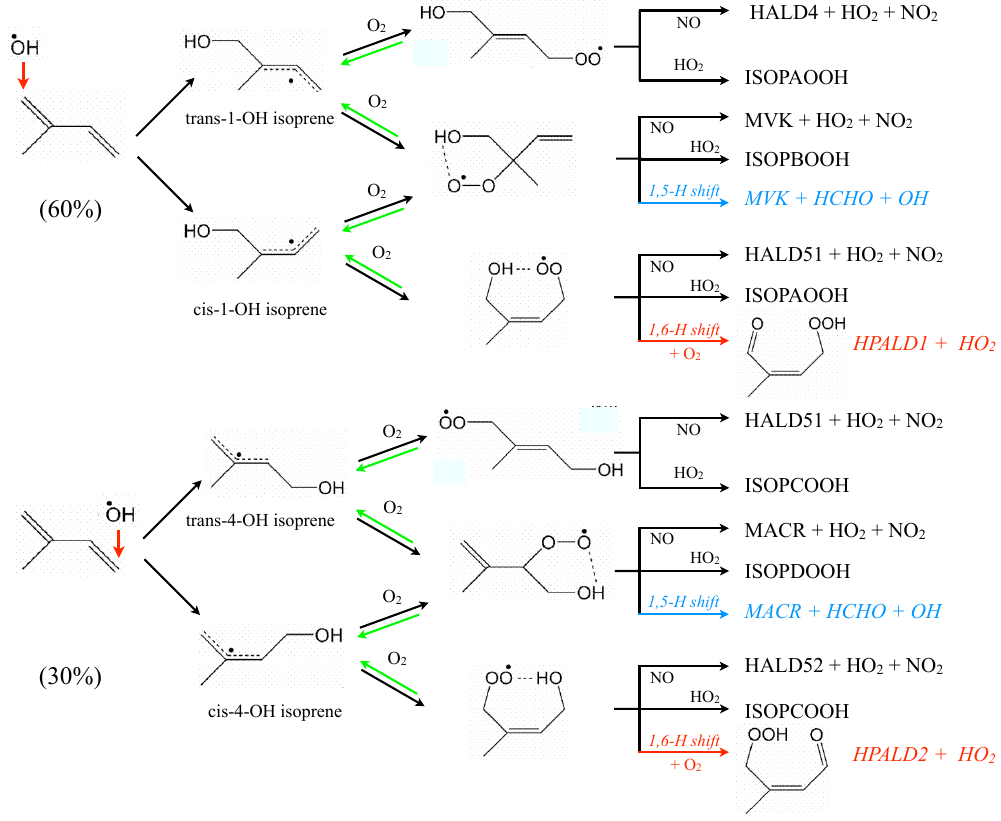
Fig. 1. Reaction scheme for OH addition to isoprene following Peeters et al. (2009). The minor addition channels (inner carbons 2 and 3) are not shown. HALD4, HALD51 and HALD52 are the C 4 and C 5 hydroxy-aldehydes formed in the NO-reaction of the δ -hydroxyperoxys (see Park et al. (2004) and references